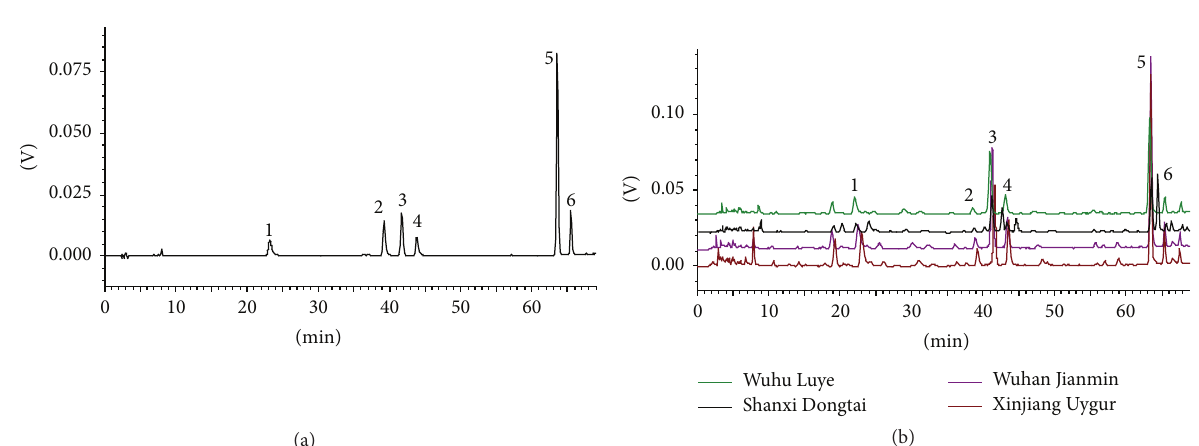
Figure 4: Typical HPLC chromatograms of Yixin Badiranjibuya Granule samples. (a) Mixed reference compounds. (b) Samples from four differentmanufacturers(1:luteolin-7- O - 𝛽 -D-glucuronide;2:apigenin-7- O - 𝛽 -D-glucuronide;3:diosmetin-7- O - 𝛽